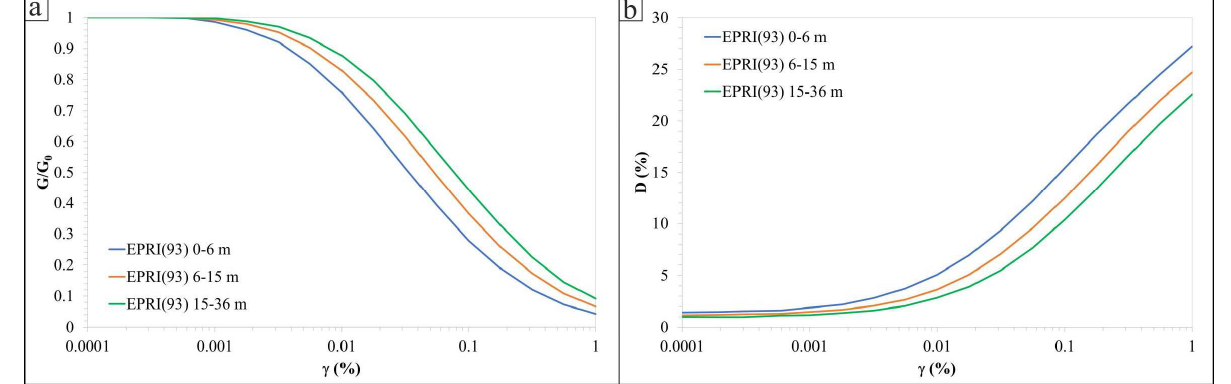
Figure 9. ( a ) G( g )/G 0 and ( b ) D( g ) EPRI (93) curves used for both 2D numerical simulations. Figure 9. ( a ) G( γ )/G 0 and ( b ) D( γ ) EPRI (93) curves used for both 2D numerical